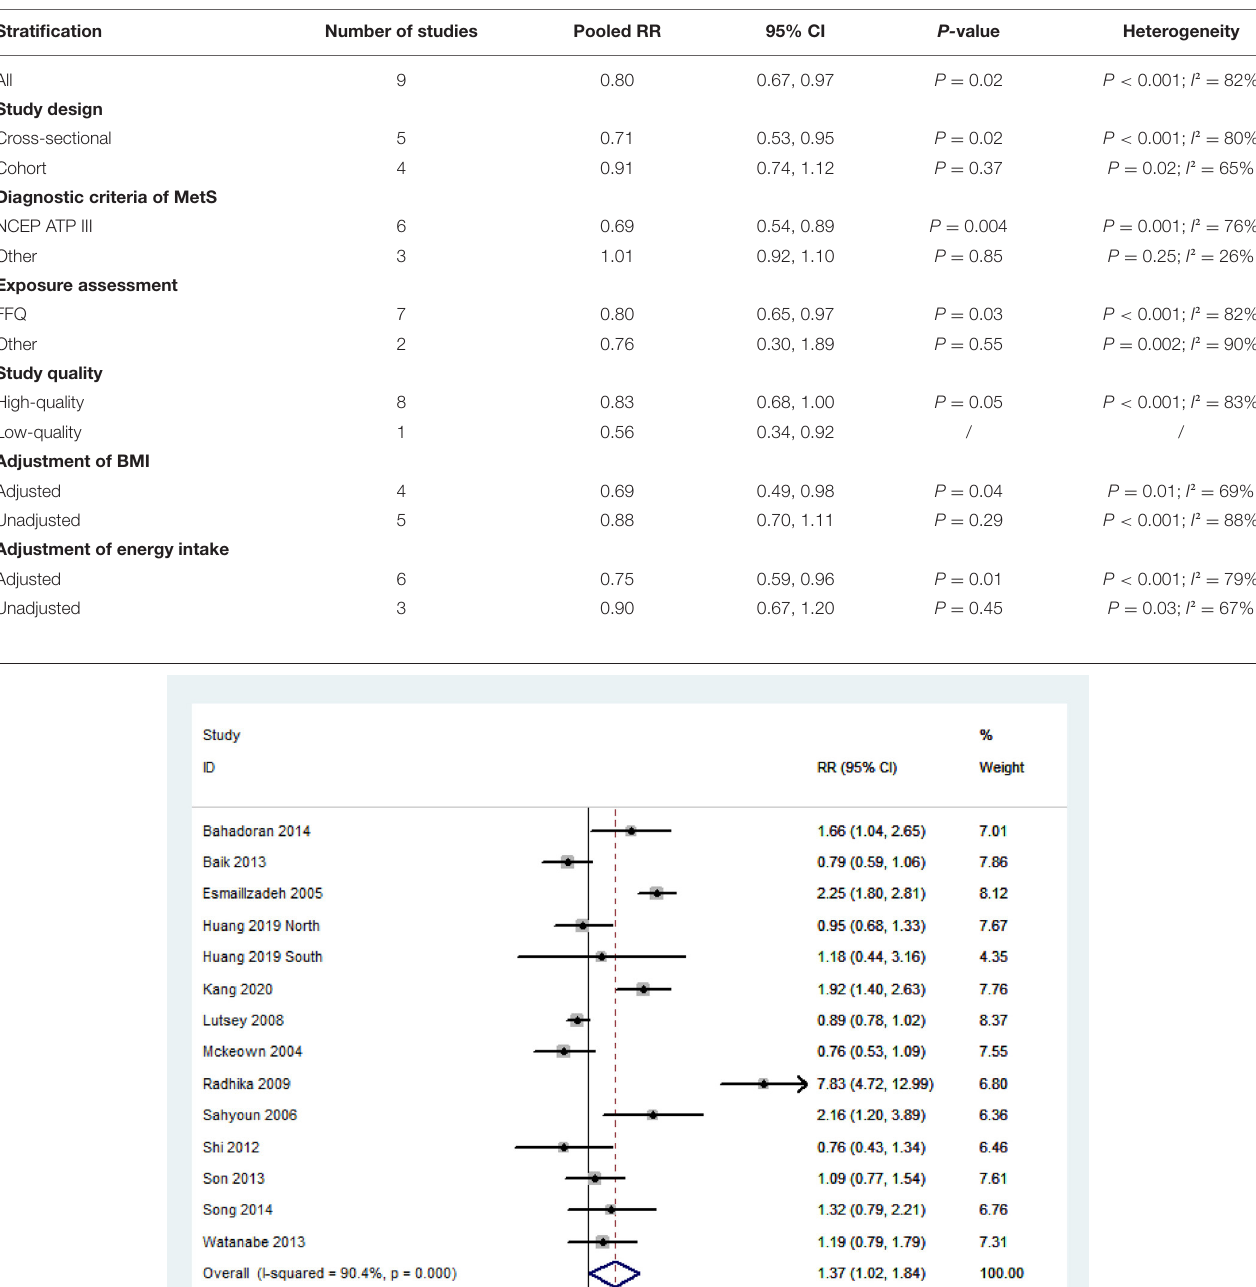
limited number of observational studies were identified for this meta-analysis. Third, the classification of exposure may vary greatly among individuals. Fourth, the diagnostic criteria of MetS and the selection of adjusted factors were not